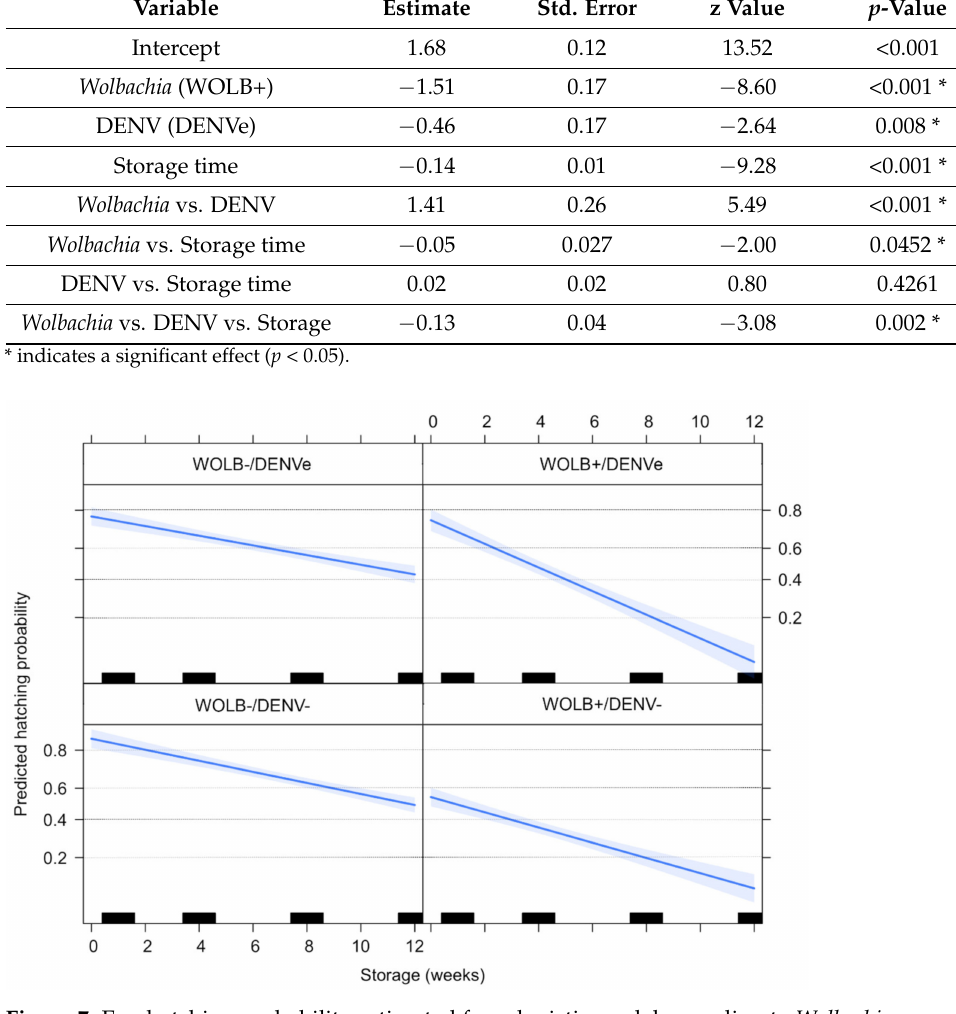
Figure 7. Egg hatching probability estimated from logistic model according to Wolbachia presence, DENV exposure status and egg storage time. Bars and blue line represent the weeks in which eggs were hatched and the estimated effect of storage time on egg viability,